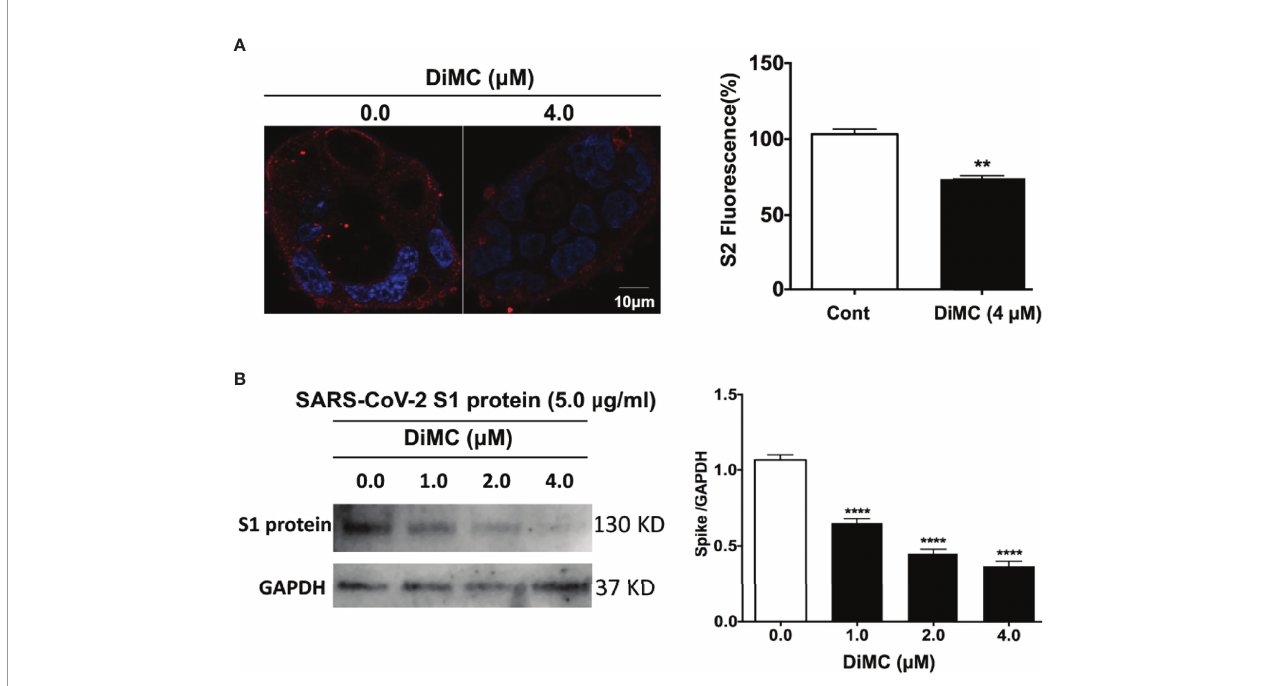
FIGURE 4 | DiMC decreased cellular levels of pseudo-SARS-CoV-2 and SARS-CoV-2 S1 proteins: (A) In pseudo-SARS-CoV-2 infected Calu-3 cells, DiMC (4.0 µM for 18 h) decreased spike protein expression levels in Calu-3 cells (bar = 10 µm; n = 3, **p <0.01). (B) In Calu-3 cells treated with SARS-CoV-2 spike protein (5.0 µg/